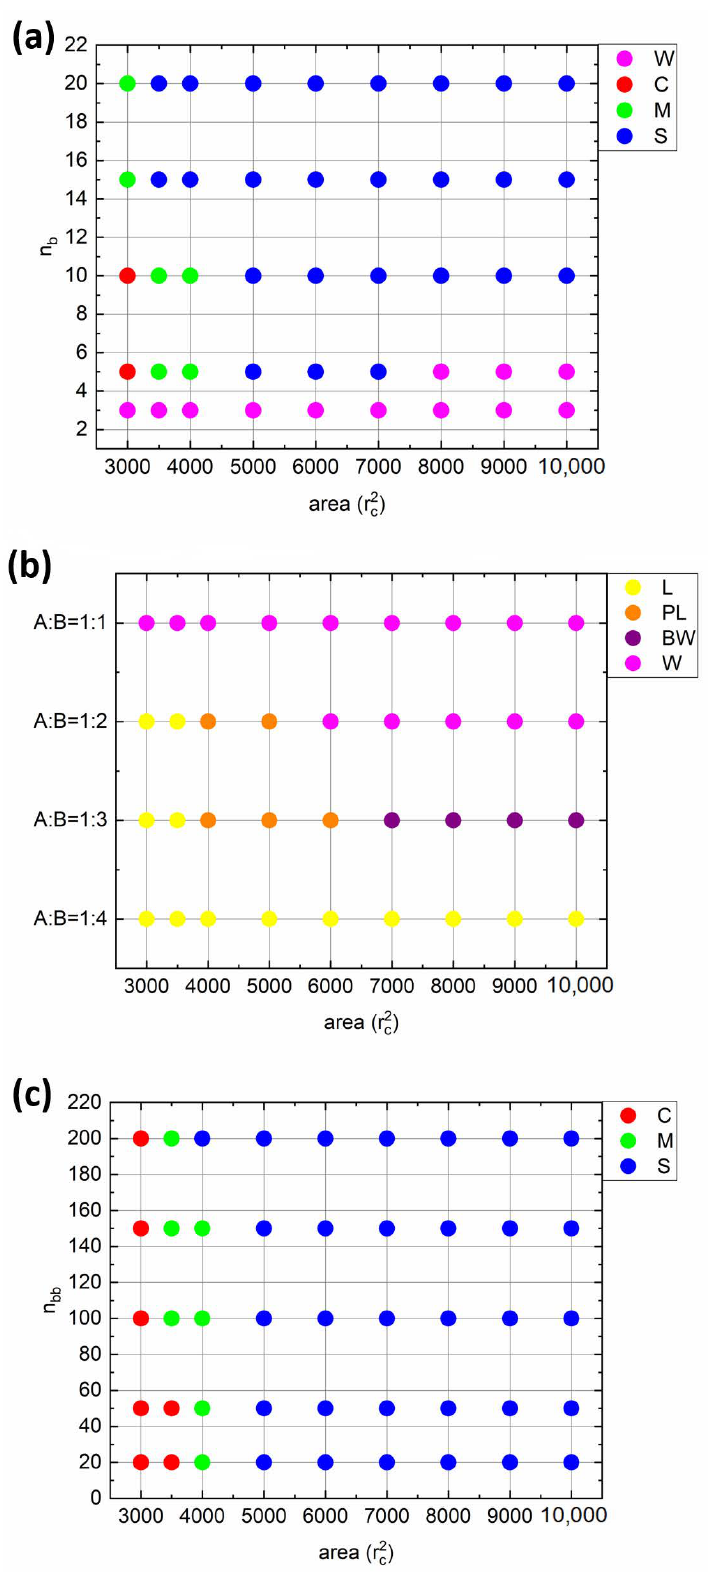
Figure 8. Diagrams of states of the interfacial bottlebrush monolayer depending on the degree of compression and ( a ) solvophobic side chain length ( n bb = 100 and f a = 0.5), ( b ) ratio between solvophilic and solvophobic side chain A:B ( n b = 3 and n bb = 100); and ( c ) backbone length ( n b = 10 and f a =